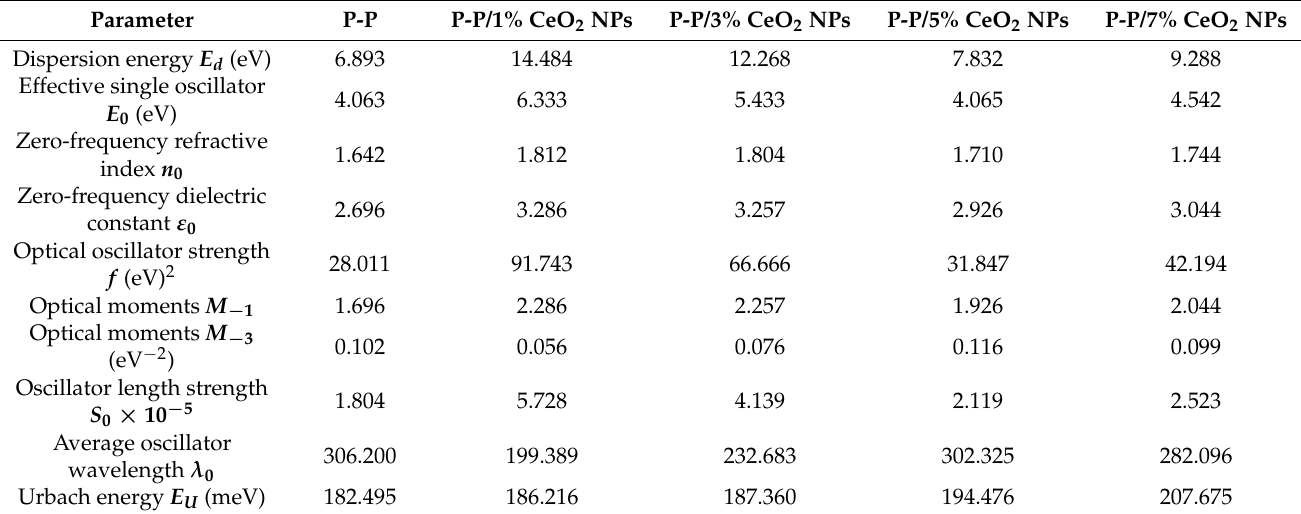
Figure 7. ( a ) The ( n 2 − 1) − 1 versus ( hv ) 2 ; ( b ) The ( n 2 − 1) − 1 versus ( λ ) − 2 of (PMMA-PS)/CeO 2 nanocomposite thin films with various CeO 2 NPs concentrations. Table 1. Some optical parameters for PMMA-PS and PMMA-PS incorporation with CeO 2 NPs.